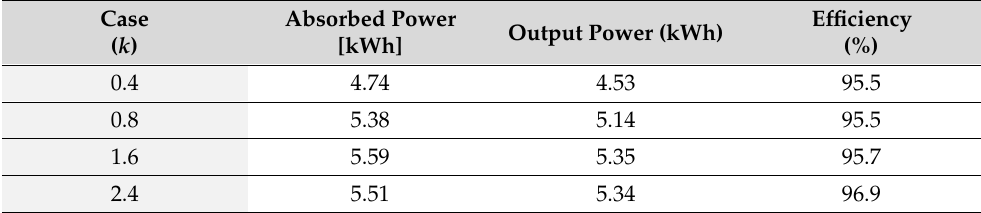
Figure 15. Power generation comparison according to torque coefficient of optimal torque control algorithm under regular wave conditions (legends indicate torque coefficients). Table 2. Input and output power according to the torque coefficient of the optimal torque control algorithm and the efficiency of the PTO system.